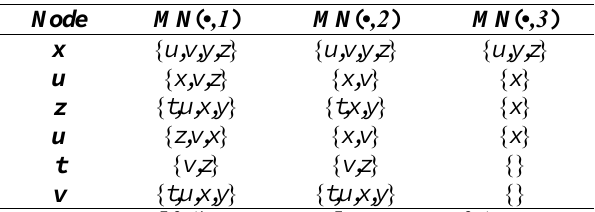
Table 2. Multi-layered neighbourhoods for the nodes from Figure